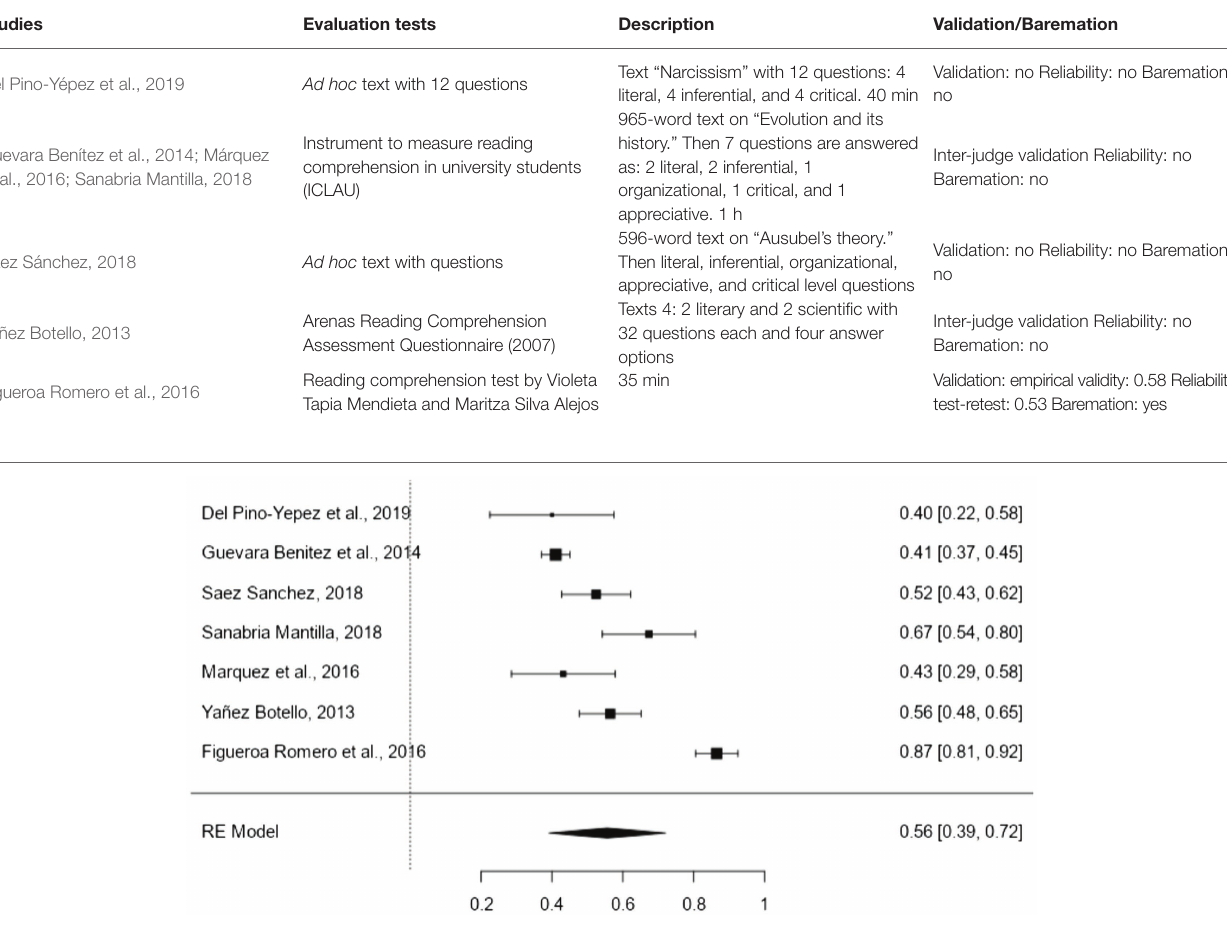
TABLE 2 | Reading comprehension assessment tests used in higher education.